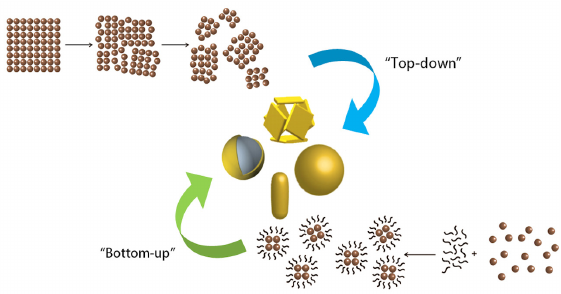
Figure 4 - Top-down and bottom-up approaches for producing controlled